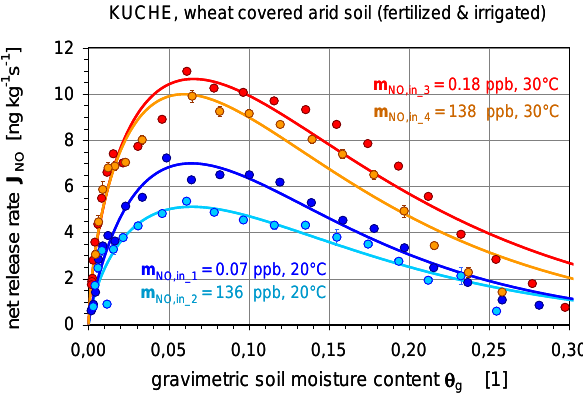
Figure 10. Net NO release rates of a sample taken from an arid, Fig. 10: Net NO release rates of a sample taken from an arid, but agriculturally managed but agriculturally managed (fertilised and irrigated) wheat covered (fertilized & irrigated) wheat covered soil in southern Xinjiang, P.R. China. soil in southern Xinjiang, P. R. China. Measurements under the four Measurements under the four conditions of exp. 1  exp. 4 (s. Section 2) have conditions of exp. 1–exp. 4 (see Sect. 2) have been performed on been performed on one single soil sample; the color code represents these four one single soil sample; the colour code represents these four condi- conditions. tions.